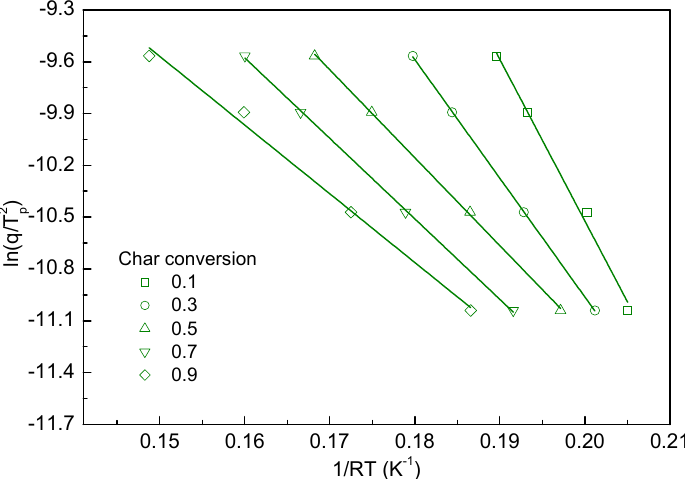
Figure 10. Kissinger kinetic plot of the kenaf char for various char conversion values and heating rates. Table 6. Activation energy for the samples at selected char conversion values. Char Conversion